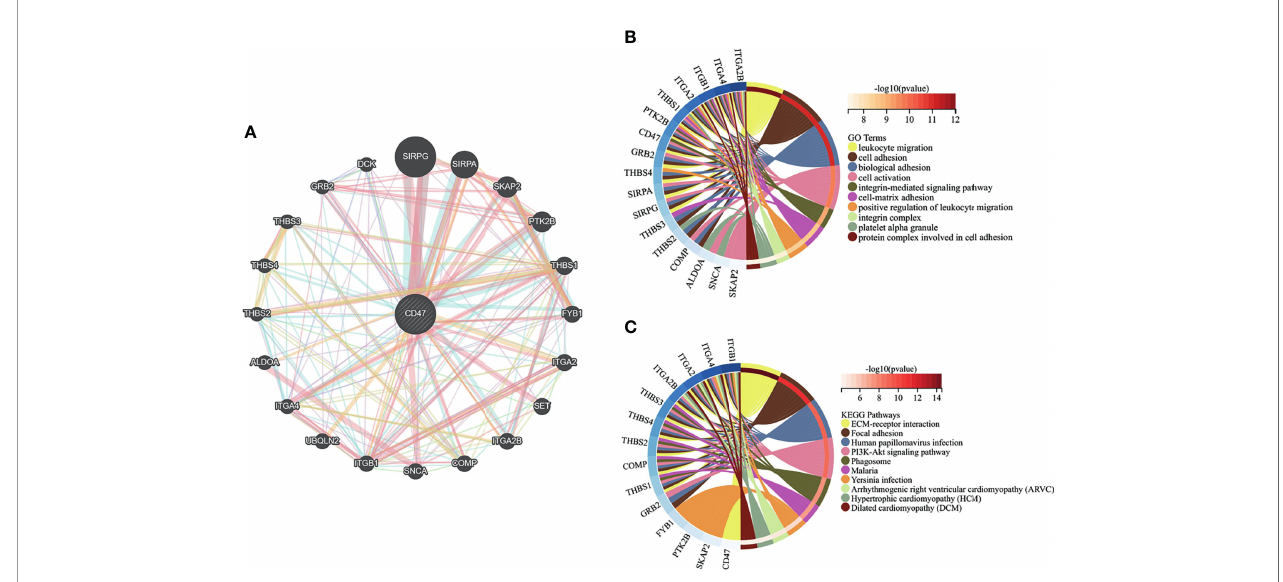
FIGURE 4 | Gene interaction network and enrichment analysis. (A) Construction of a PPI network with 21 genes centered on CD47; (B) Top 10 GO functional terms; (C) Top 10 KEGG